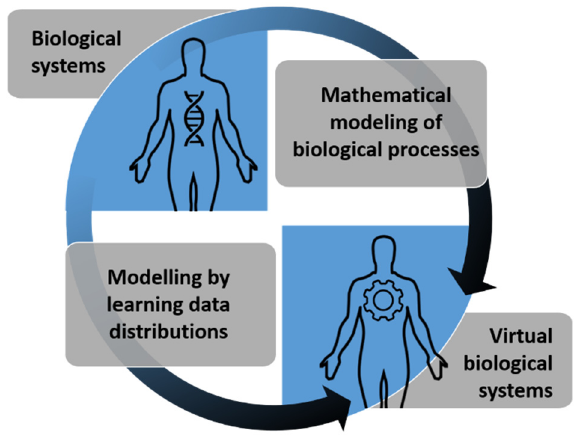
Figure 1. Two approaches to synthetic human biological systems.